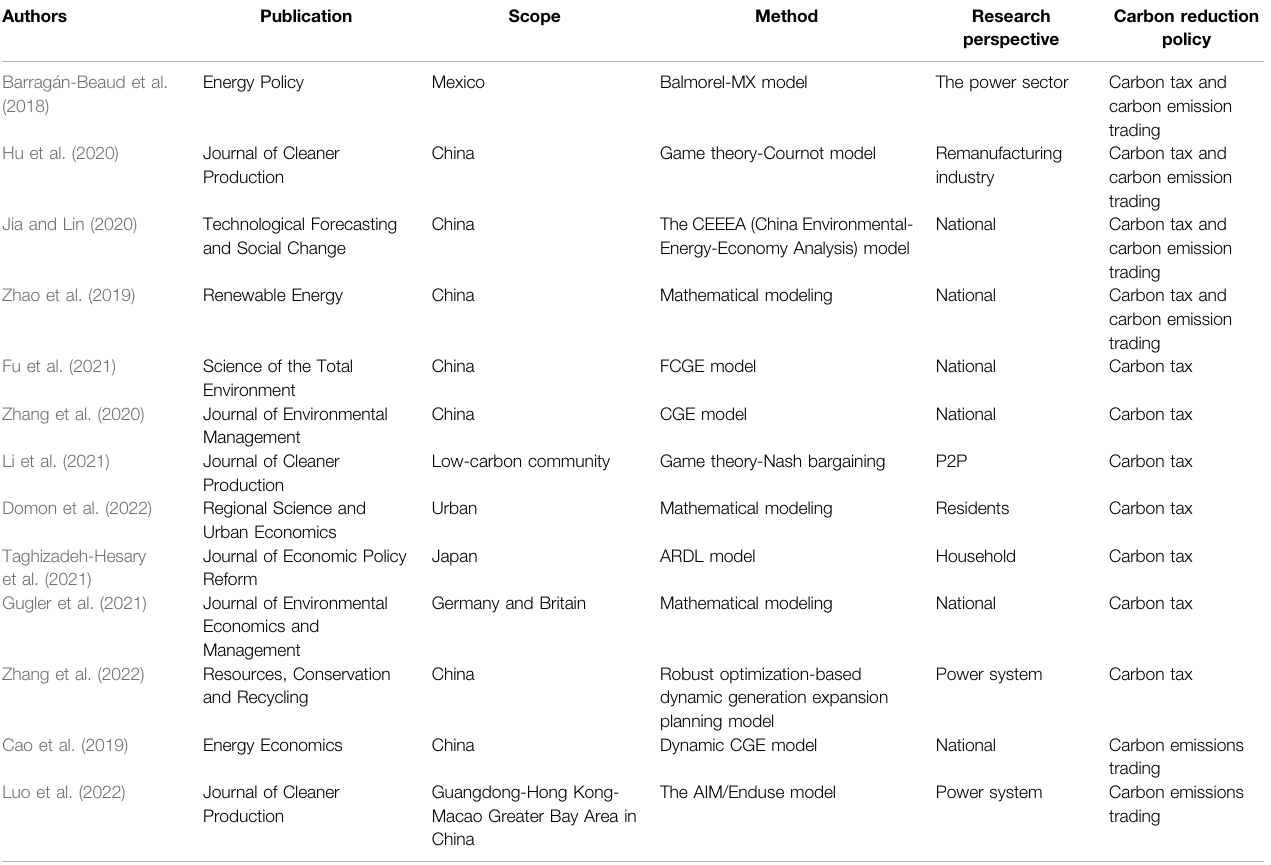
TABLE 1 | Recent studies on carbon tax and carbon emission trading